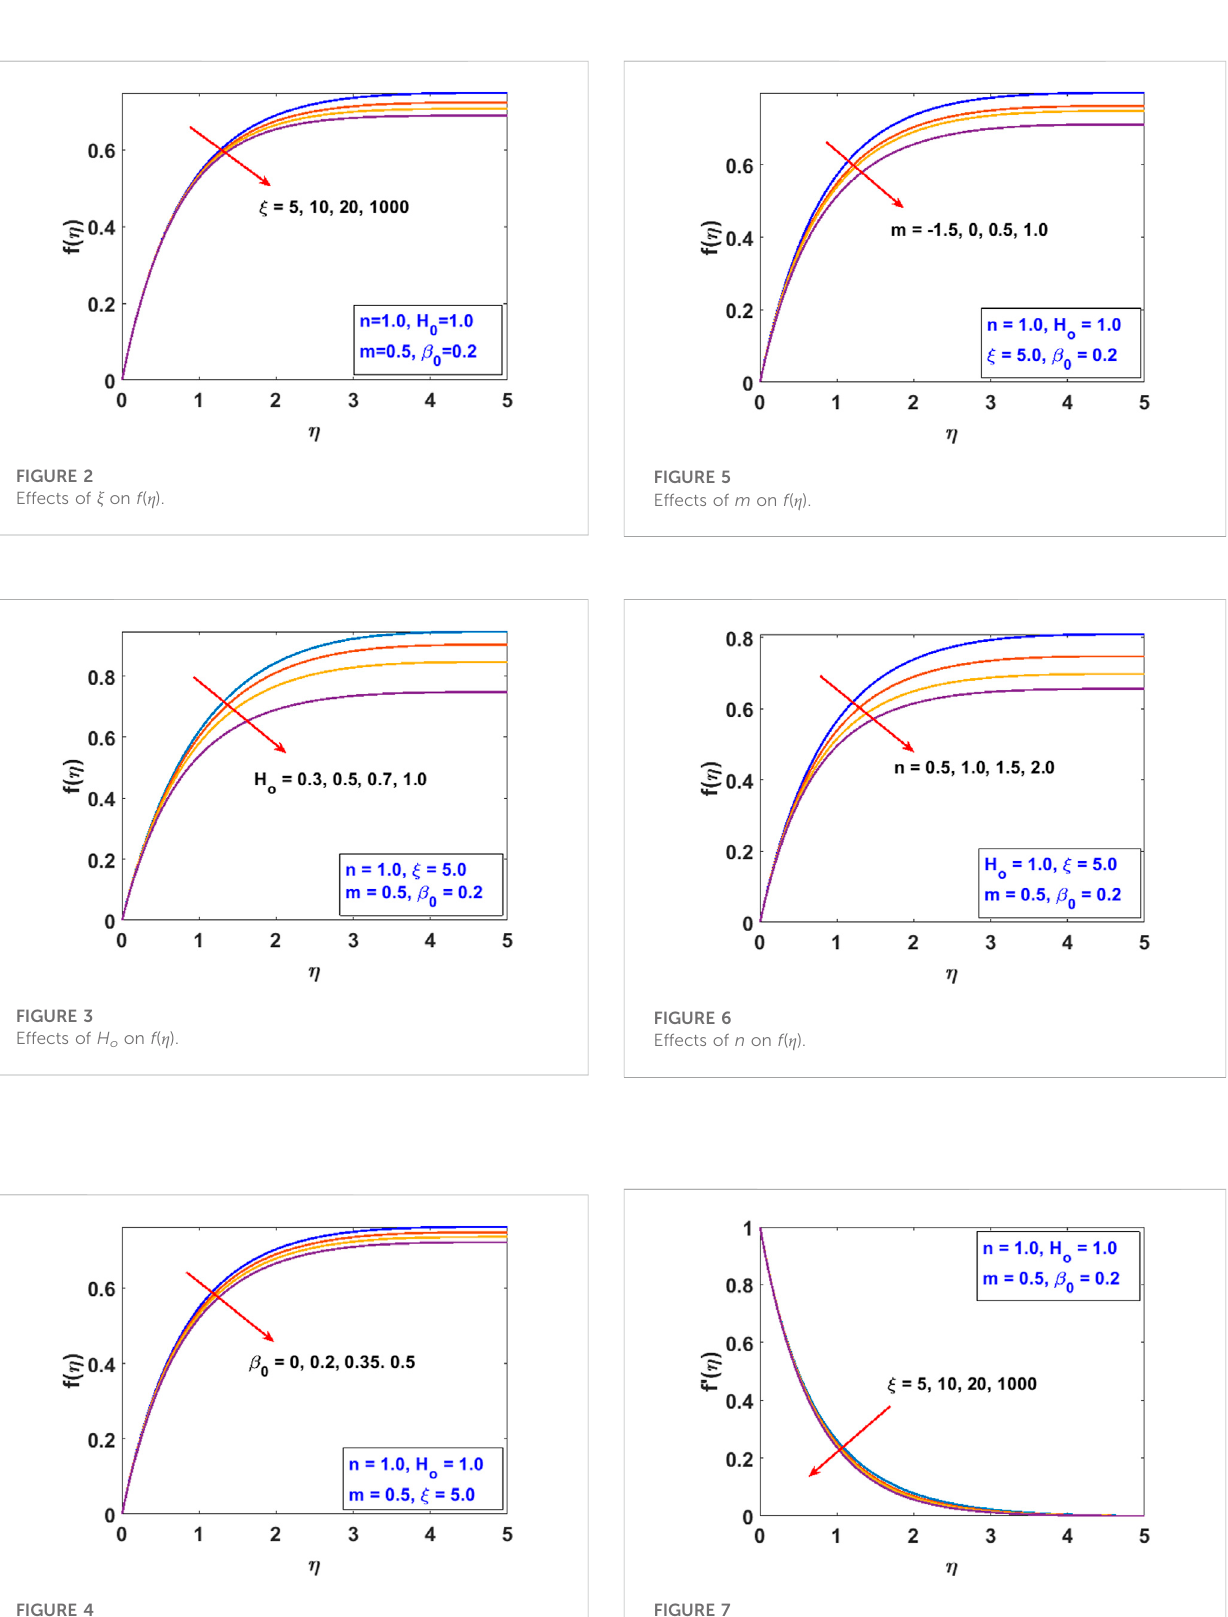
FIGURE 4 Effects of β 0 on f ( η ).